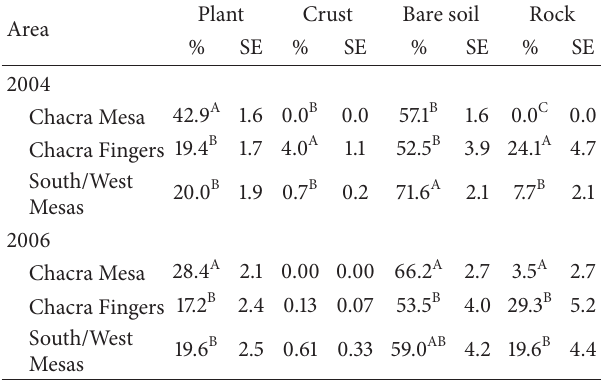
Table 2: Percent utilization (SE) of Salix spp. in Chaco Wash and Atriplex canescens in the side canyons in use and control areas, Chaco Culture National Historical Park, April 2004–2007. Salix spp. Atriplex canescens Year